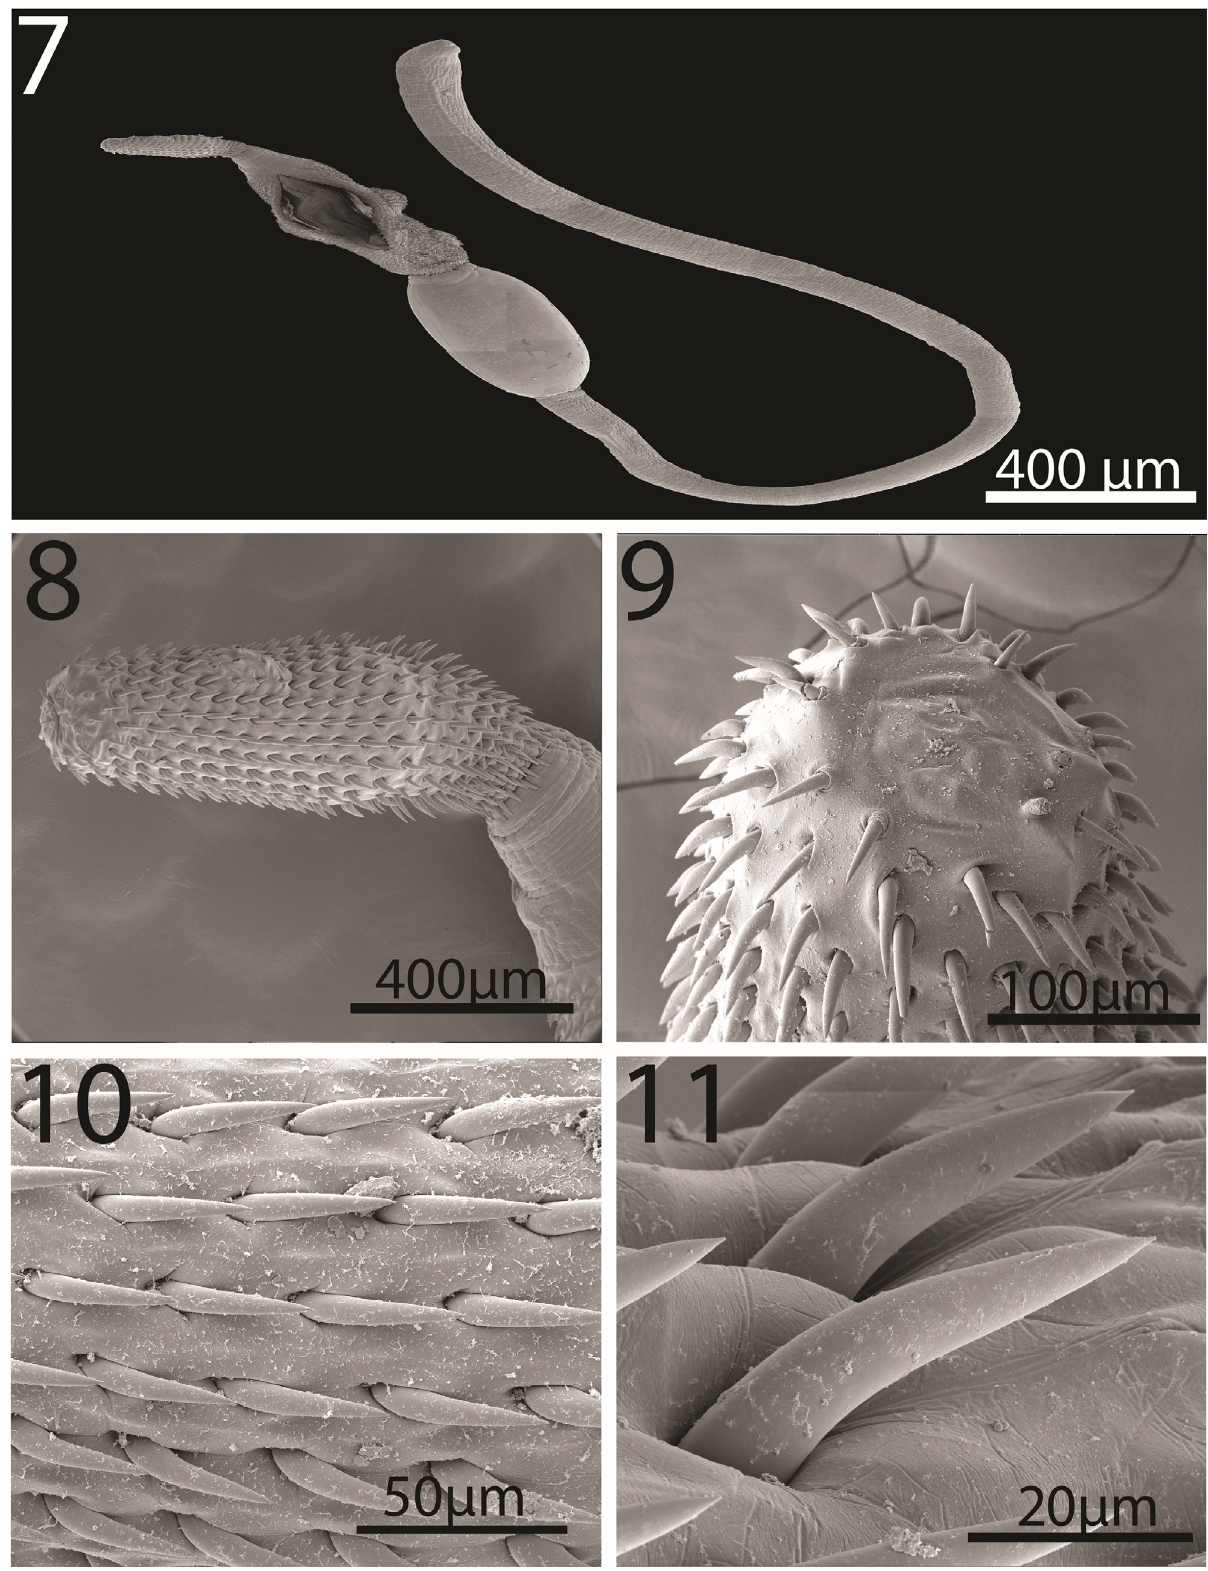
Figures 7-11. SEM of cystacanths of Neoandracantha peruensis from ghost crabs, Ocypode gaudichaudii , from the Paci fi c Ocean off Peru. 7. Allotype female. The foretrunk was slit open intentionally. 8. The proboscis of the allotype female in Figure 1. 9. The apical end of the proboscis showing its unarmed tip. 10. Proboscis hooks at the middle of the proboscis. 11. A few enlarged hooks showing their shape and orientation on the